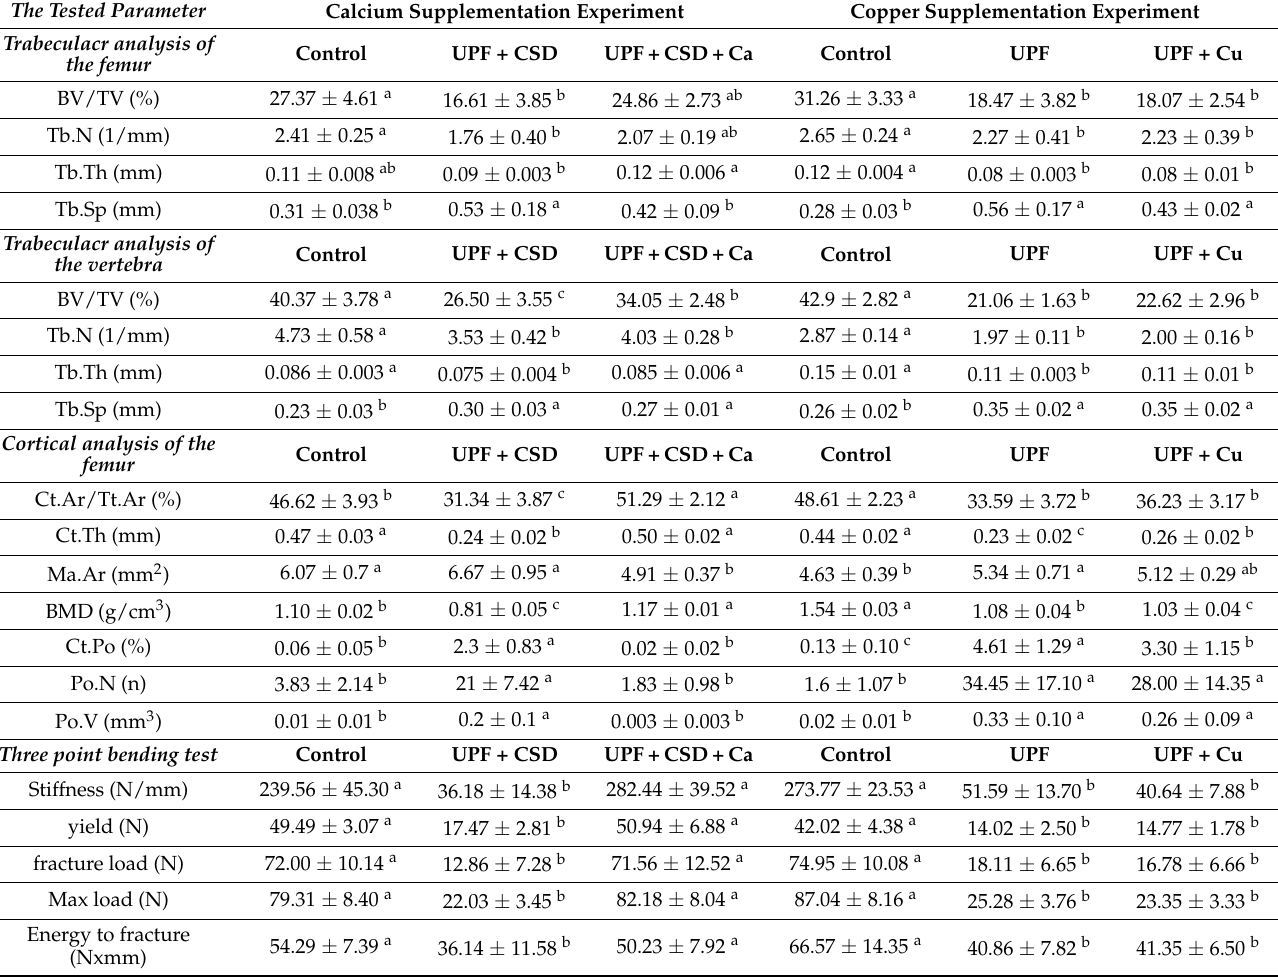
Table 1. Consumption of ultra-processed diet leads to alterations in bone architecture and biome- chanical